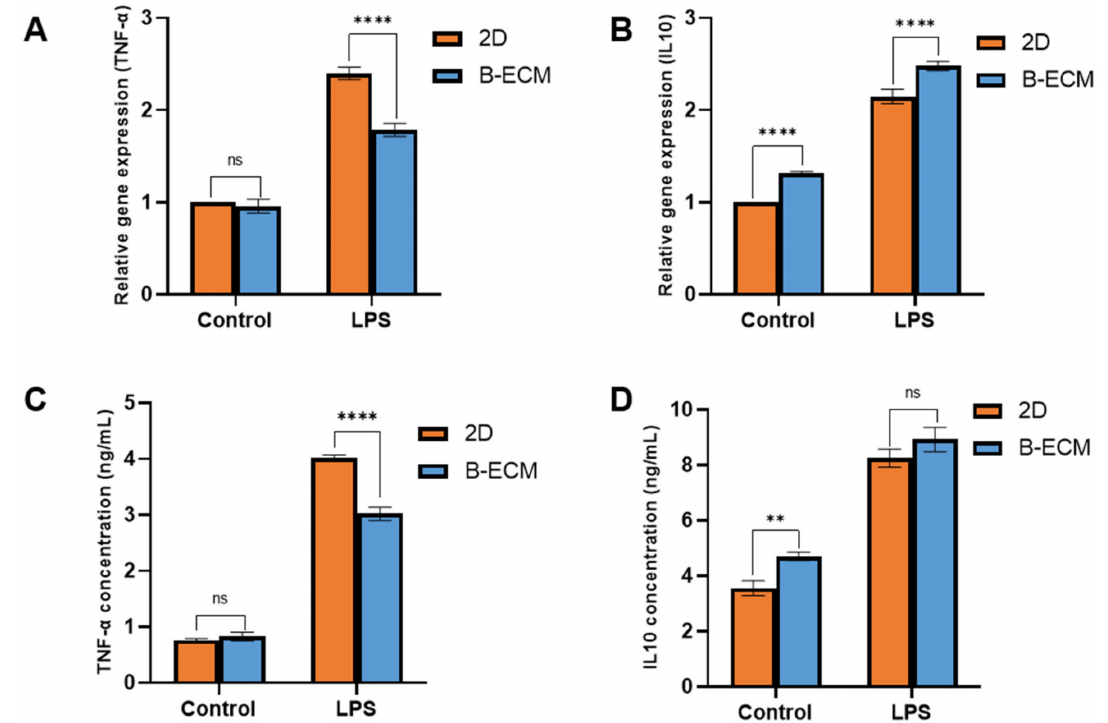
Figure 6. Immunomodulatory effect of digested B-ECM towards RAW cells under aseptic and septic conditions. Relative expression of TNF- α ( A ) and IL10 ( B ) genes by qPCR. TNF- α ( C ), IL-10 ( D ) concentration in cell culture supernatant by ELISA assay with ns being no significant, ** p ≤ 0.01, and **** p ≤ 0.0001.